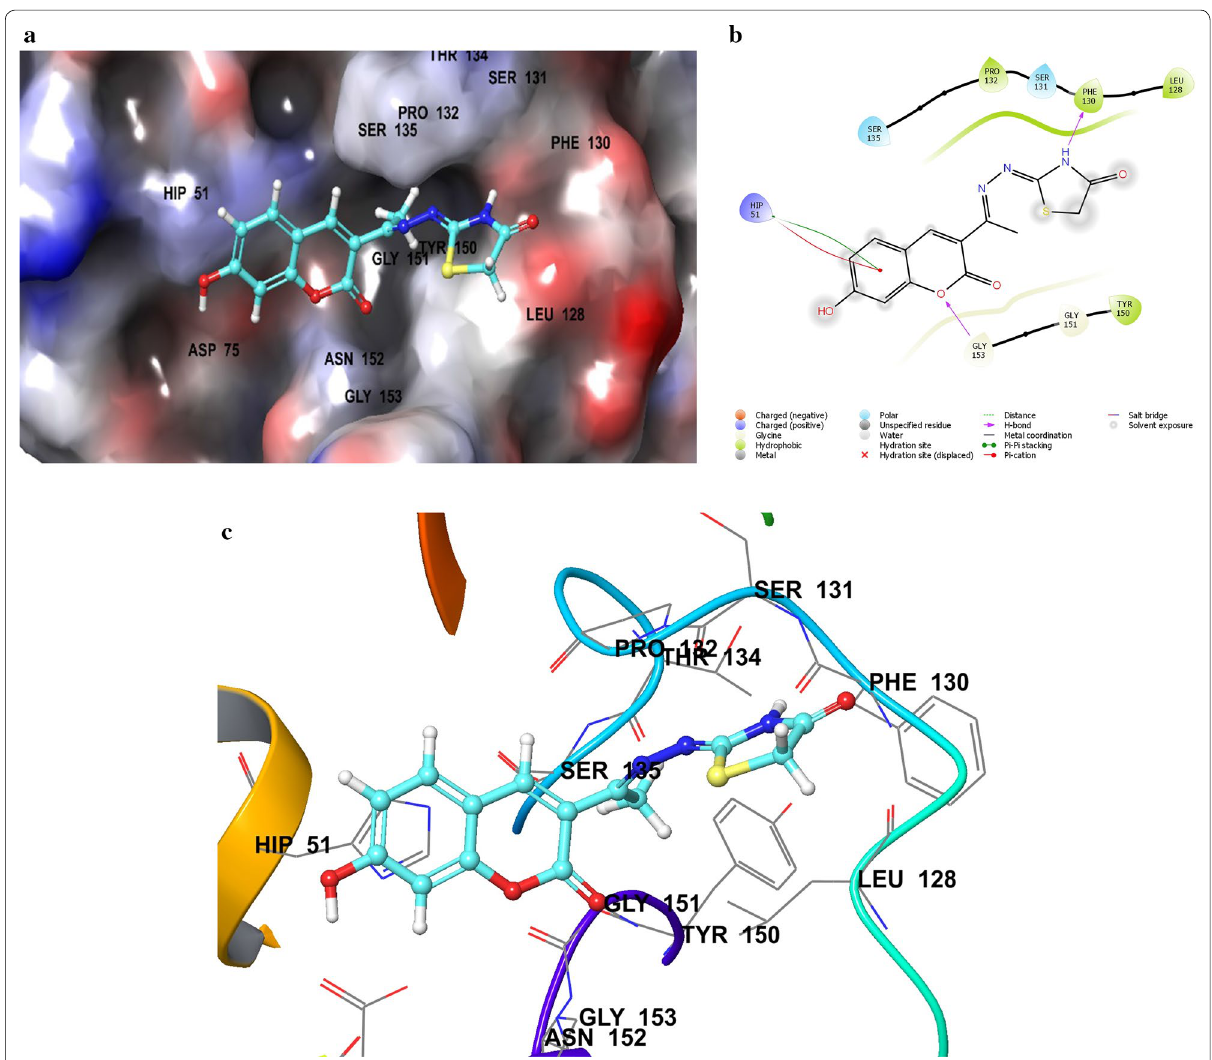
Fig. 8 Binding modes of compound SKYc with dengue virus NS2B/NS3 protease: a Protein as surface and compound as sticks; b Protein and compound as 2D interaction image; c Protein as ribbon and compound as